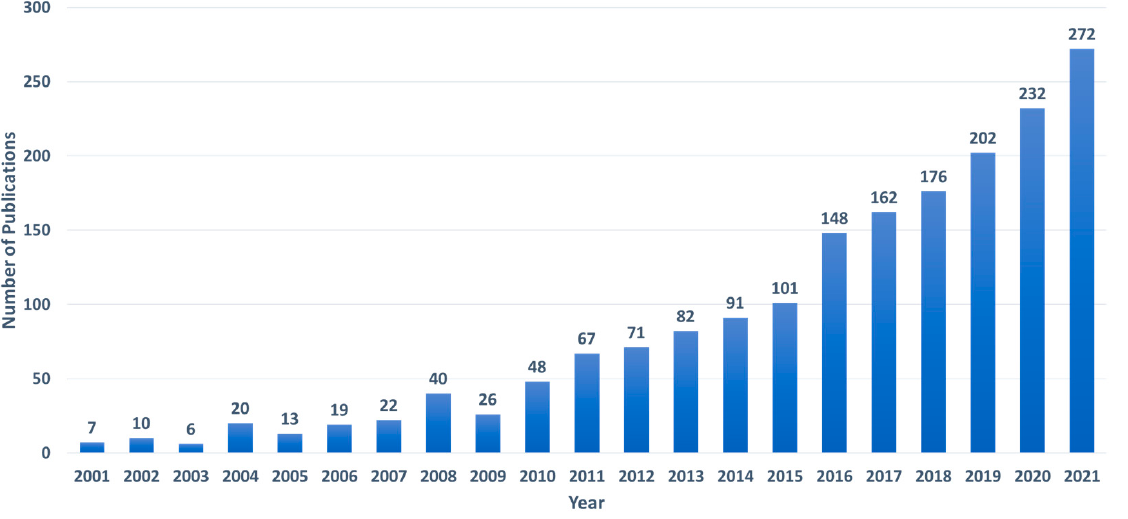
Figure 3. The number of articles published each year employs a handheld Raman equipment to identify the substance.